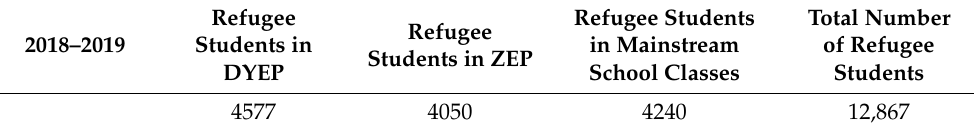
Table 1. Total Number of Refugee Students in Greek School in the Academic Year 2018–2019. (https://www.minedu.gov.gr/tothema-prosfigiko-m, accessed on 2 March